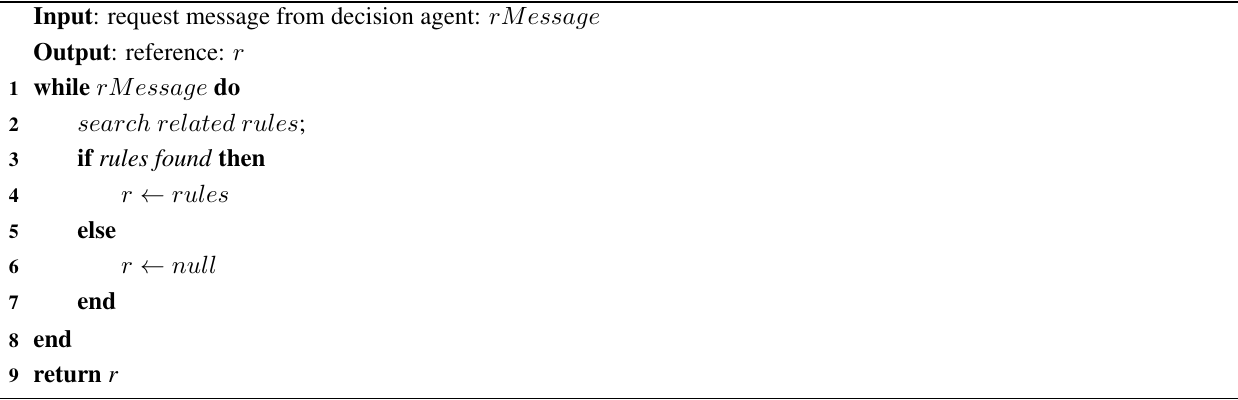
Algorithm 4 : Database agent behavior.